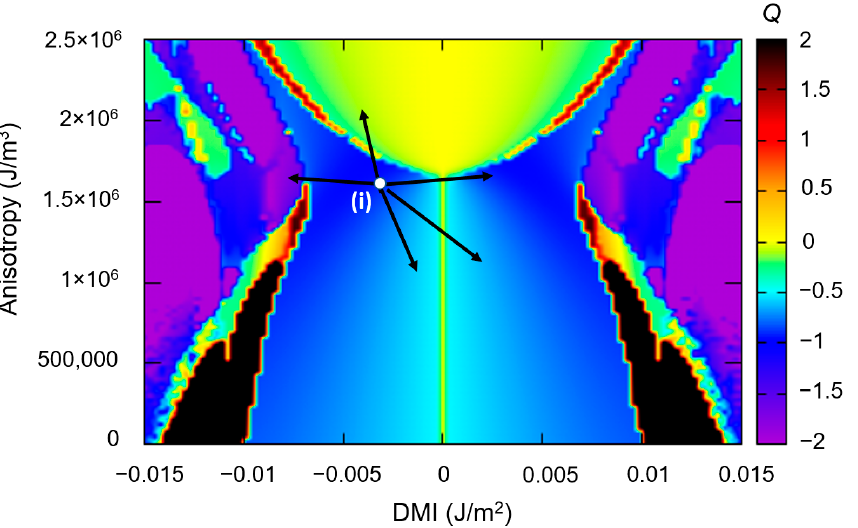
Figure 28. Possible paths of “motion” within a DMI-PMA-Q diagram, starting from an initial point (i), e.g., by electric field gating. The magnetic parameters used in Mumax3 are those for the diagram illustrated in Figures 13 and 15.